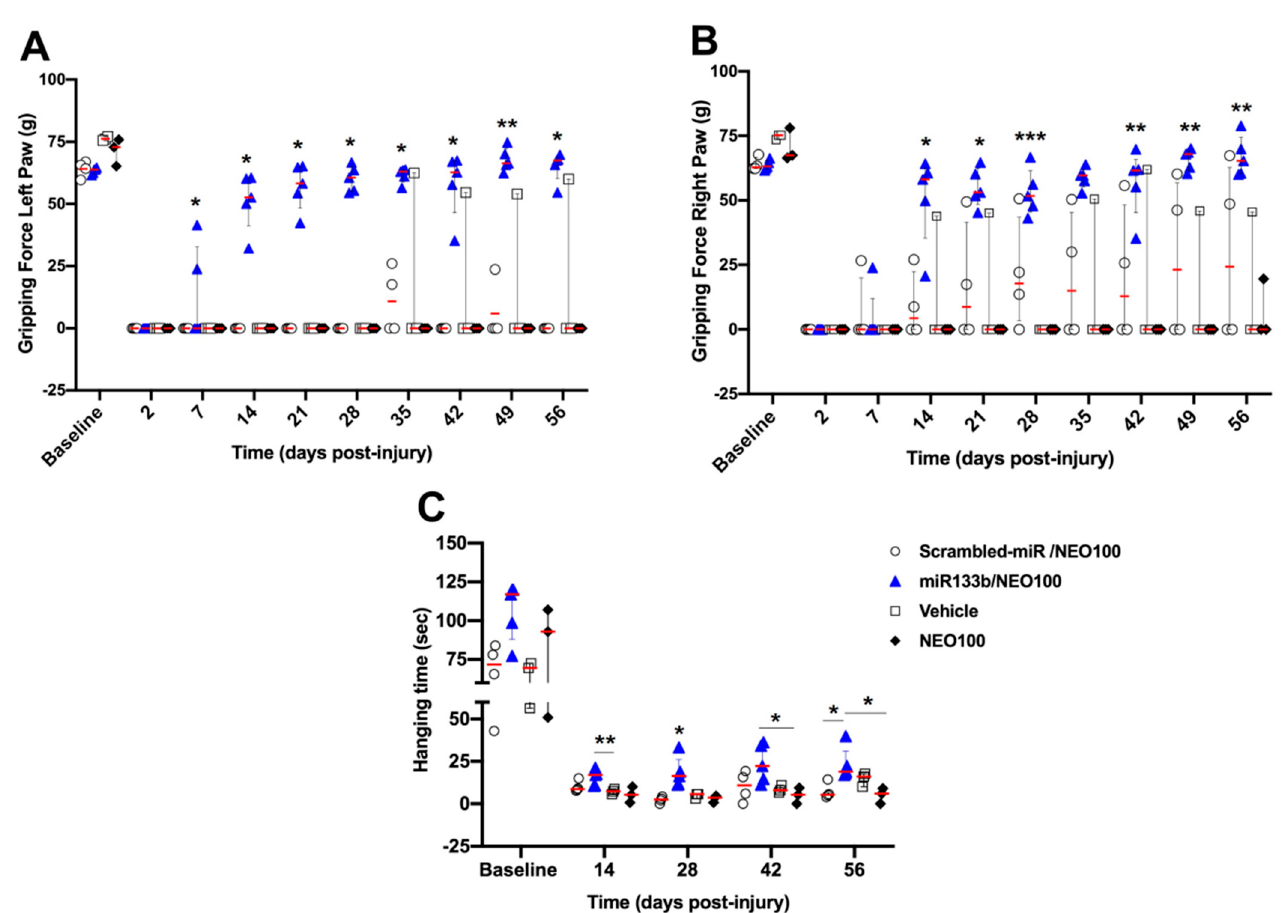
Figure 5. The effect of intranasal co − delivery of miR133b/Ago2 with 1%NEO100 on forelimb gripping and grasping recovery. The graphs represent the forelimb gripping (panels A , B ) and grasping (panel C ) assessments during 56 days post − injury (DPI) in miR133b/Ago2/NEO100, scrambled − miR/NEO100, Vehicle and NEO100 only treated mice. Two − way Repeated Measures, ANOVA, followed by the Tukey’s multiple comparison test. *** p < 0.001, ** p < 0.01, * p < 0.05. The circles and triangles in each graph represent the individual mouse performance per group. The red line shows the median with interquartile range. Table 2. The comparison between gripping and grasping tasks in treated groups with and without NEO100 at the end of study (56 days post-SCI). Data are expressed as mean ± SEM. Experimental